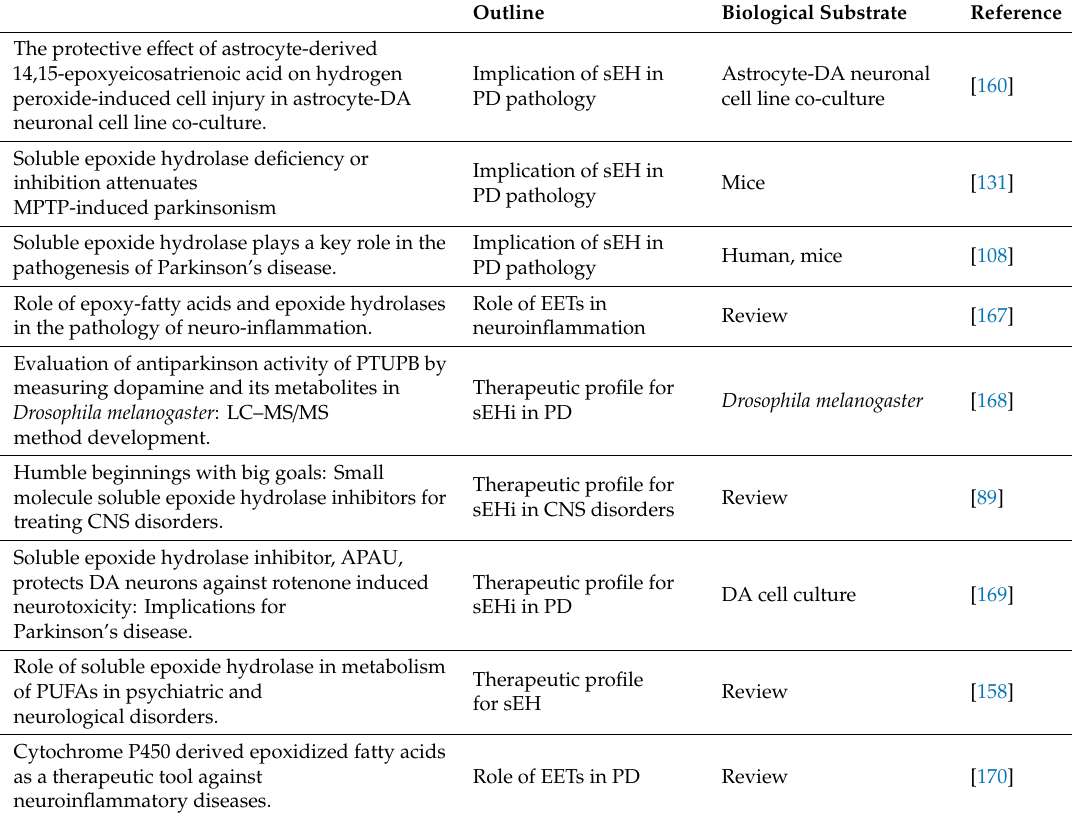
Table 1. Publications crosslinking sEH and PD or other central nervous system (CNS)